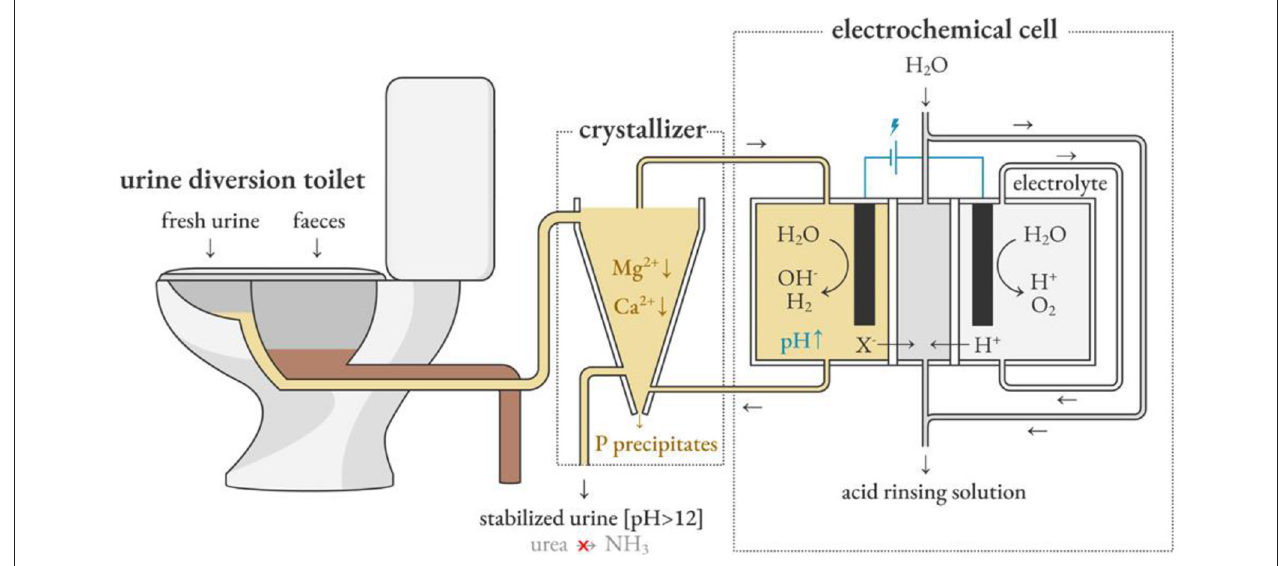
FIGURE 7 | Electrochemically induced precipitation stabilizes fresh urine and promotes source separation. Reprinted with permission from De Paepe et al. (2020). Copyright © 2020 American Chemical Society.